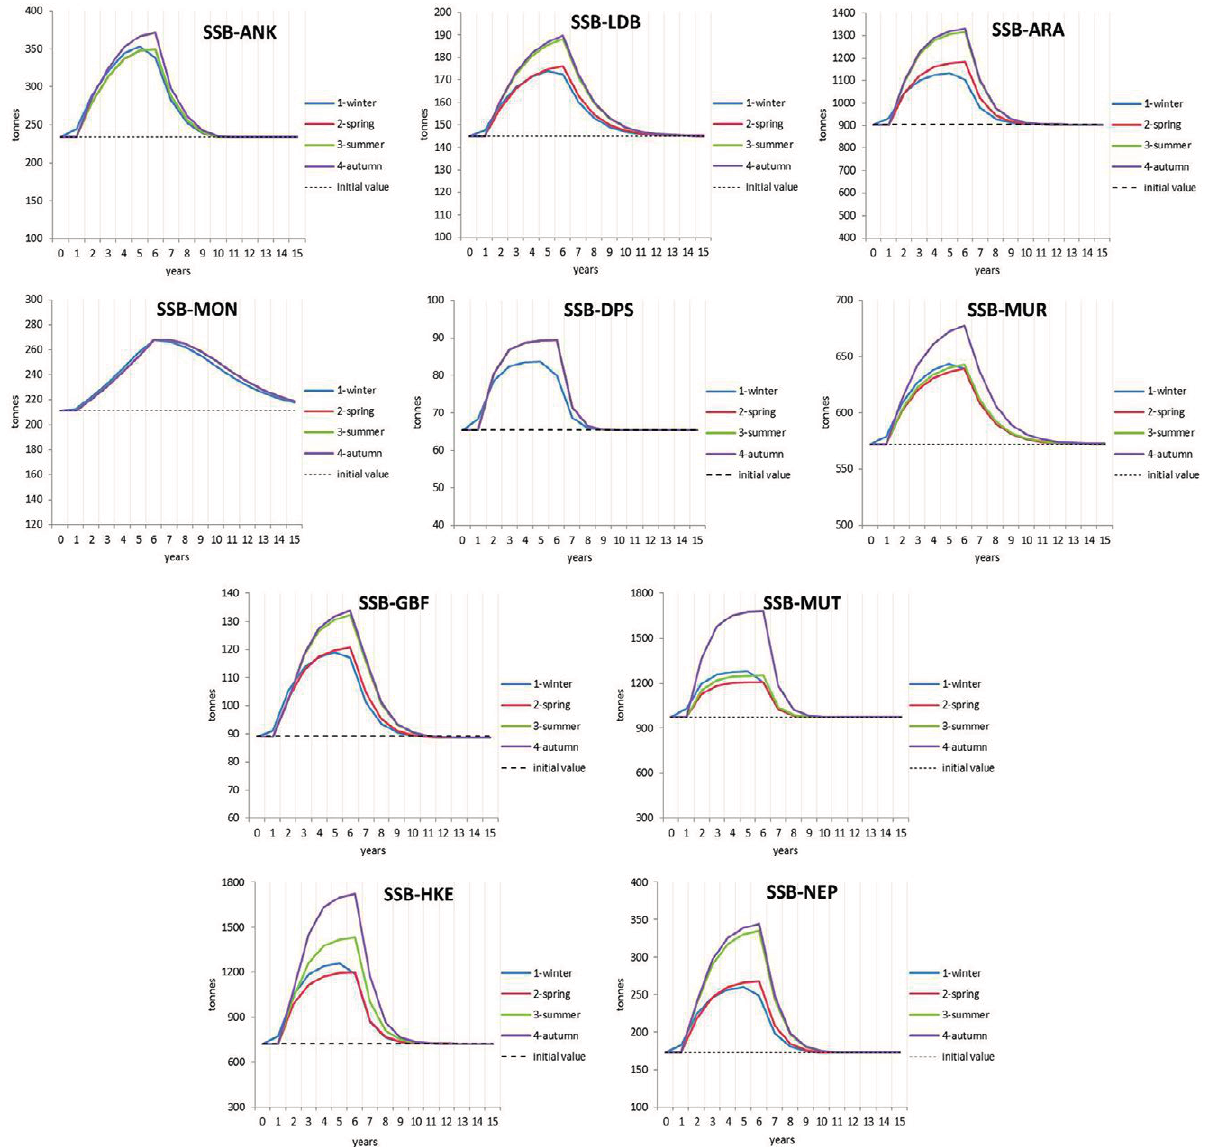
Fig. 5. – SSB trend over 15 years of simulation under the implementation of a three-month closure for the otter bottom trawl fleets in winter, spring, summer and